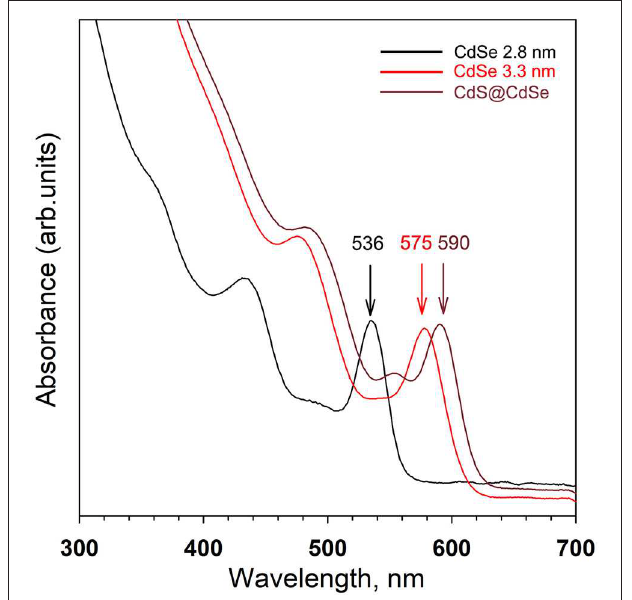
FIGURE 3 | Optical absorption spectra of CdSe and CdS@CdSe nanocrystals.